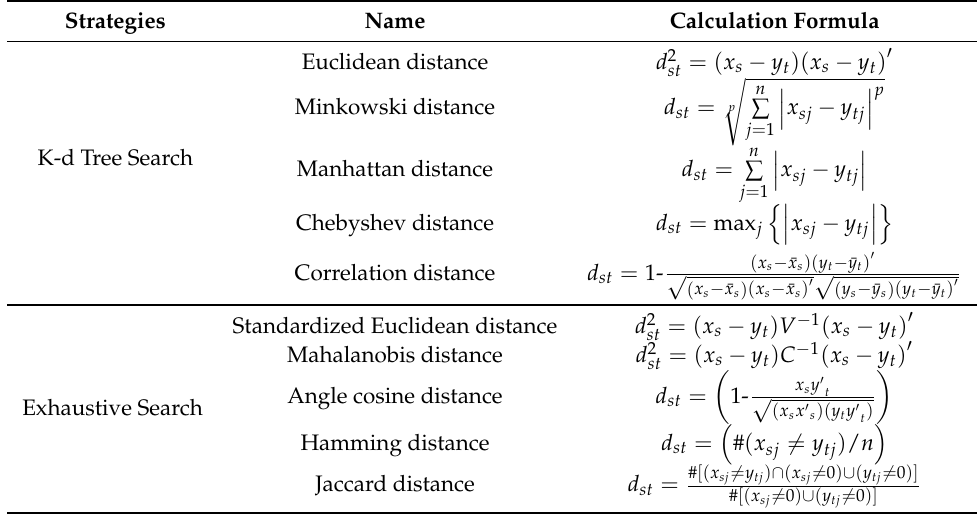
Table 1. Distance calculation